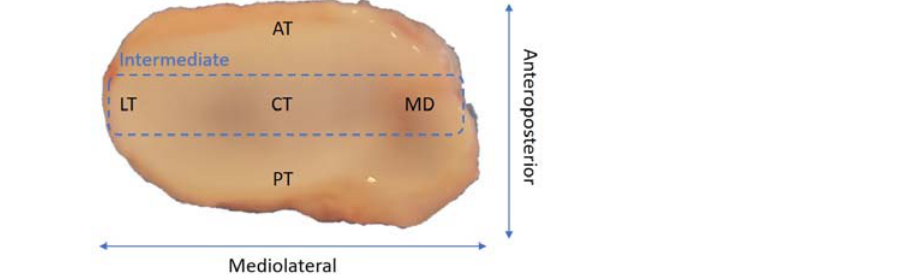
Figure 1. Different regions of the temporomandibular disc: anterior (AT), posterior (PT), lateral (LT), central (CT) and medial (MD).